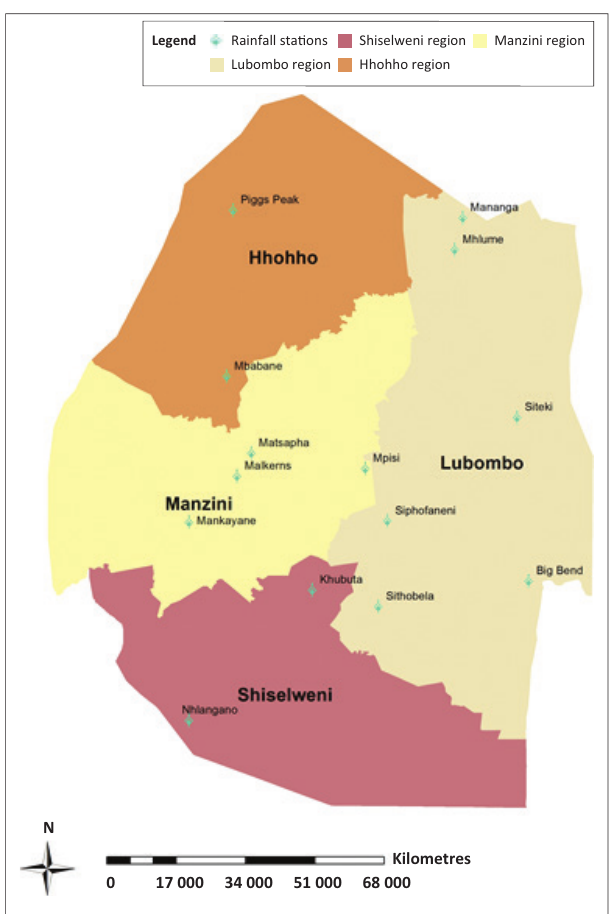
FIGURE 1: Map of Eswatini with rainfall stations used in the